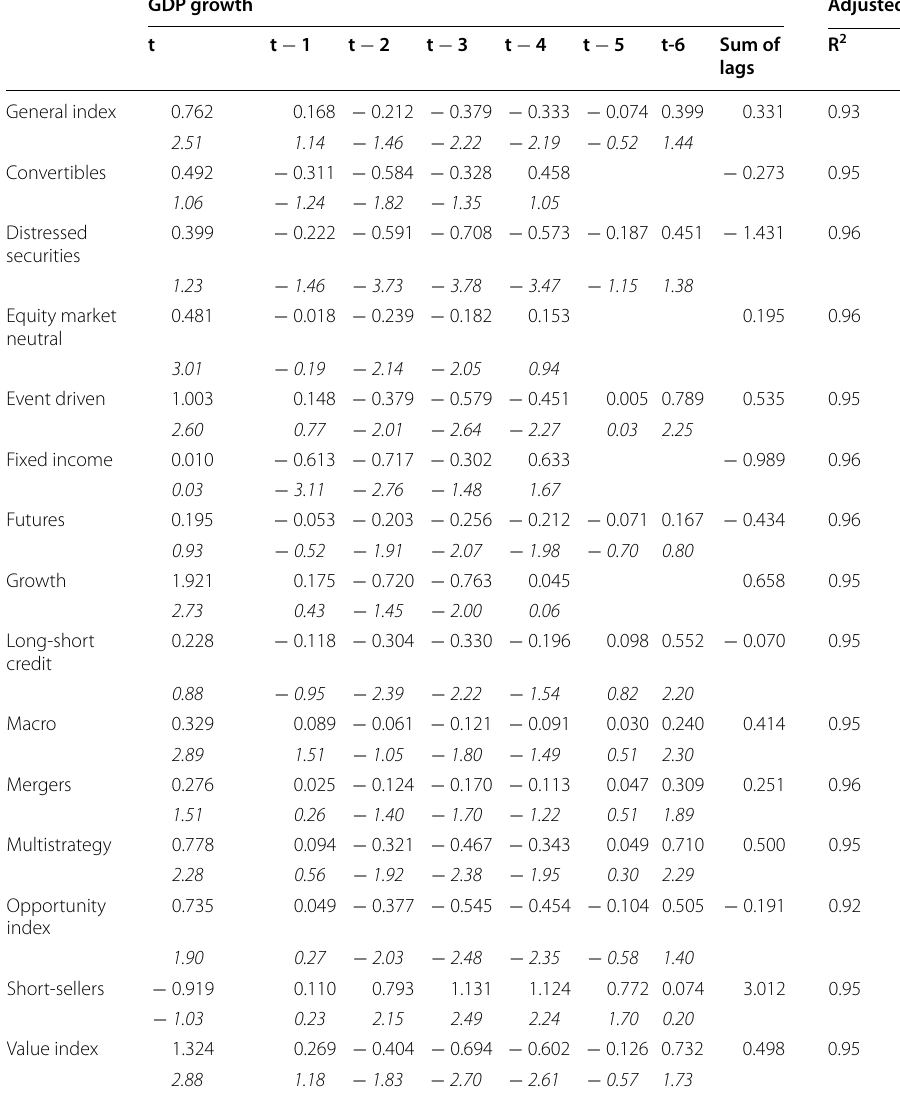
The coefficients are obtained by regressing returns on an Almon (1965) polynomial defined on GDP growth as measured with d ln GDP × 100 . The number of lags can differ from one strategy to the next. Except for short‑sellers, a positive (negative) sign for the sum of lags indicates a procyclical (contracyclical) strategy’s beta. The magnitude of the sum of lags indicates the degree of beta’s cyclicality. t‑statistics are in